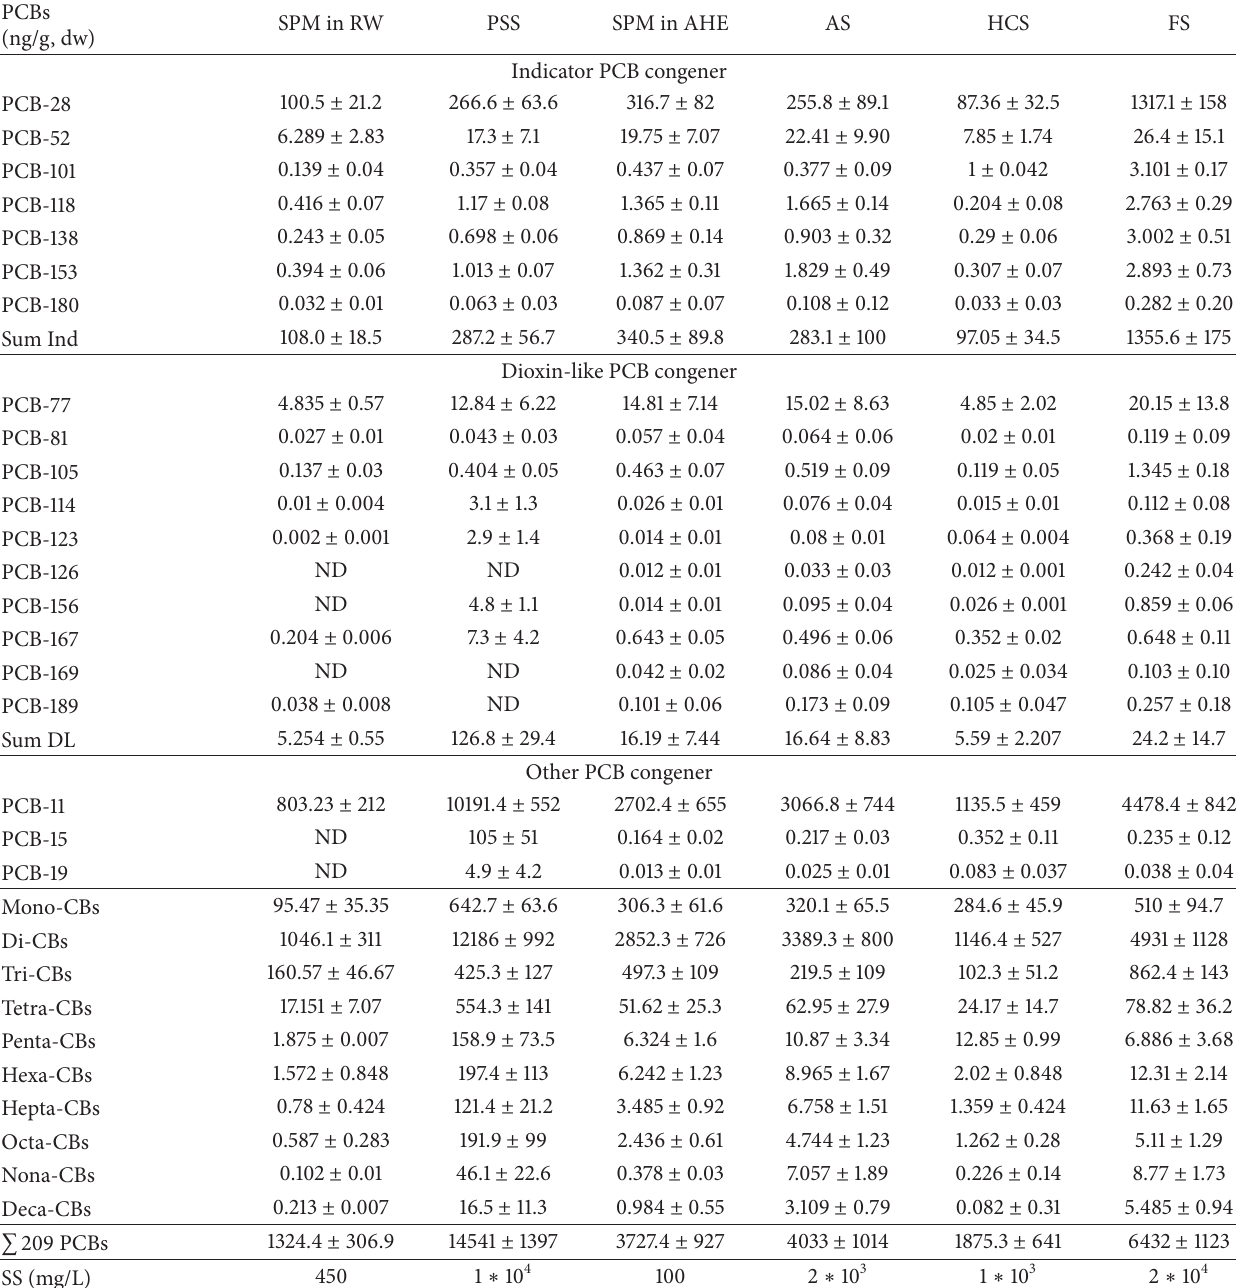
Table 3: The concentrations (means ± SD) of PCBs in SPM and sludge of each treatment stage at the